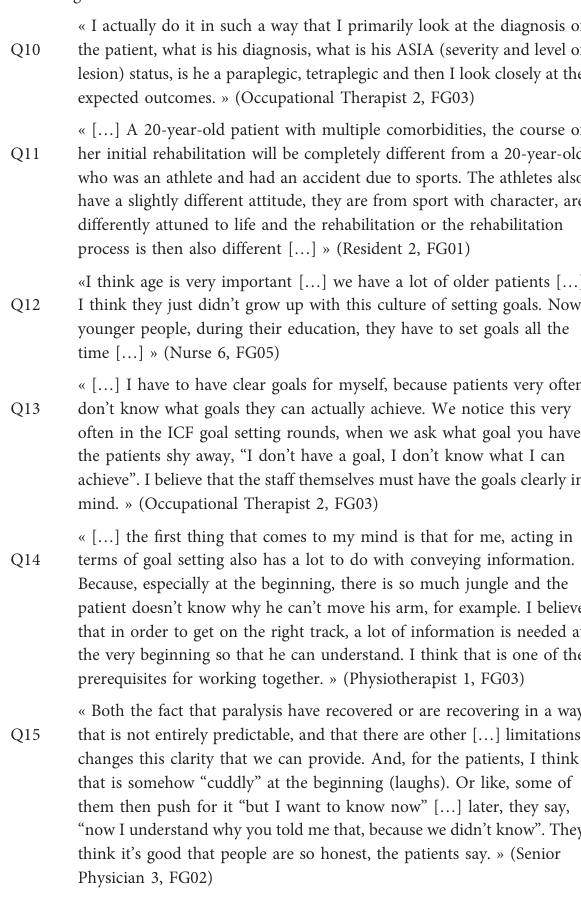
TABLE 3 The micro level - emotions. TABLE 2 The micro level -